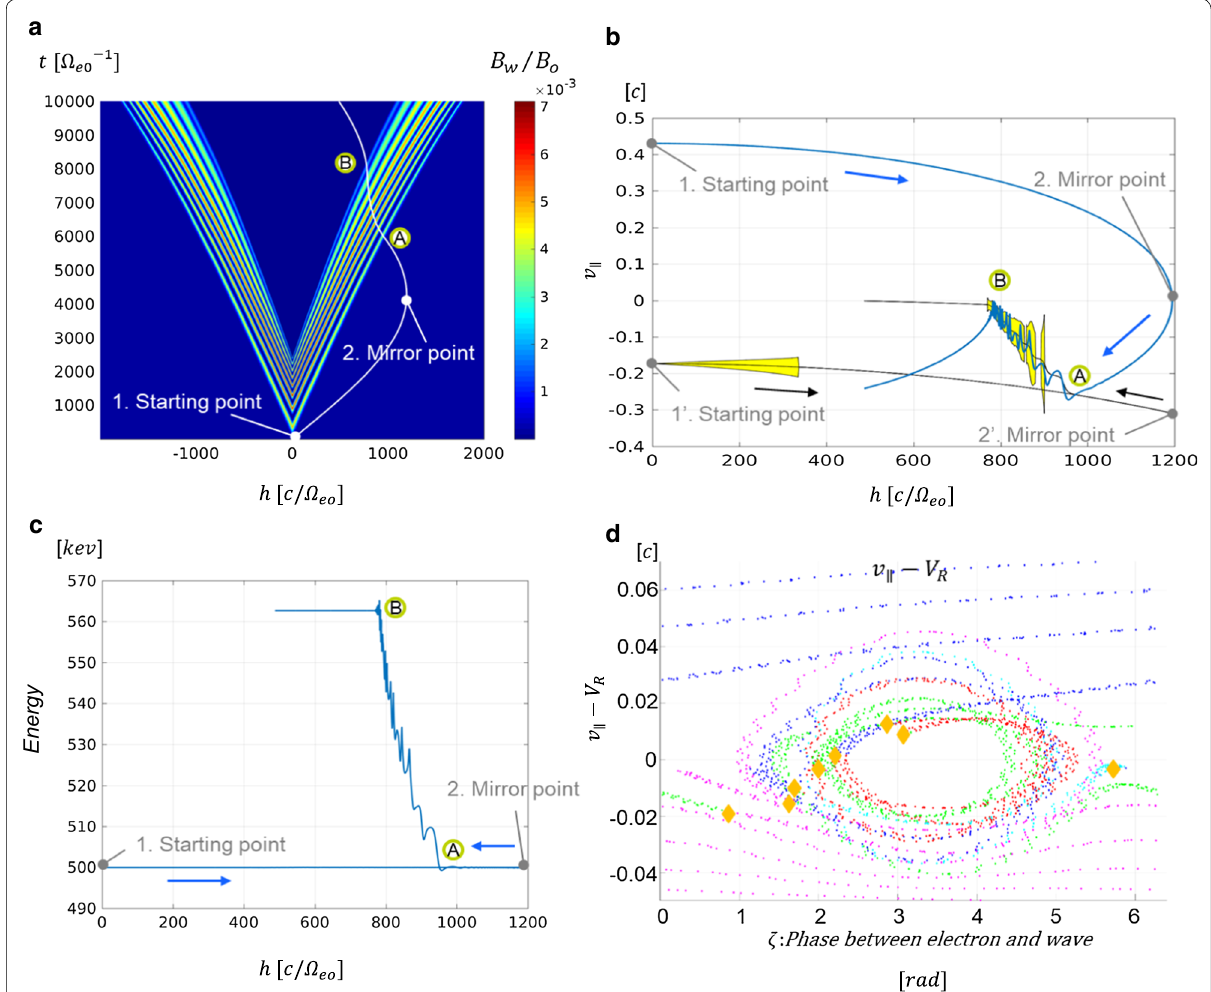
Fig. 6 Simulation results of wave–particle interaction for a sample electron with the initial energy of 500 keV and the initial equatorial pitch angle of 60°. a Spatiotemporal profile of generation and propagation of multi-subpacket chorus wave amplitude and a trajectory (white line) of the sample electron. The adiabatic motion of the electron distorted by the wave–particle interaction over location A–B. b Variation of resonance velocity V R (black line) with the trapping region (yellow region) formed around it. The blue line shows the variation of the electron velocity v trajectory of v is clearly disturbed to follow the variation of V R over location A–B, indicating the electron is entrapped and accelerated by the chorus (cid:31) wave during the interaction. c Energy variation of the sample electron resulting in energy increase of more than 60 keV. d Trajectory of the electron in the (θ ζ) phase space draws closed region, indicating the electron falls into the trapping region generated by the chorus wave. The dot color is − changed at the points where the electron starts to interact with a new subpacket and experiences a phase